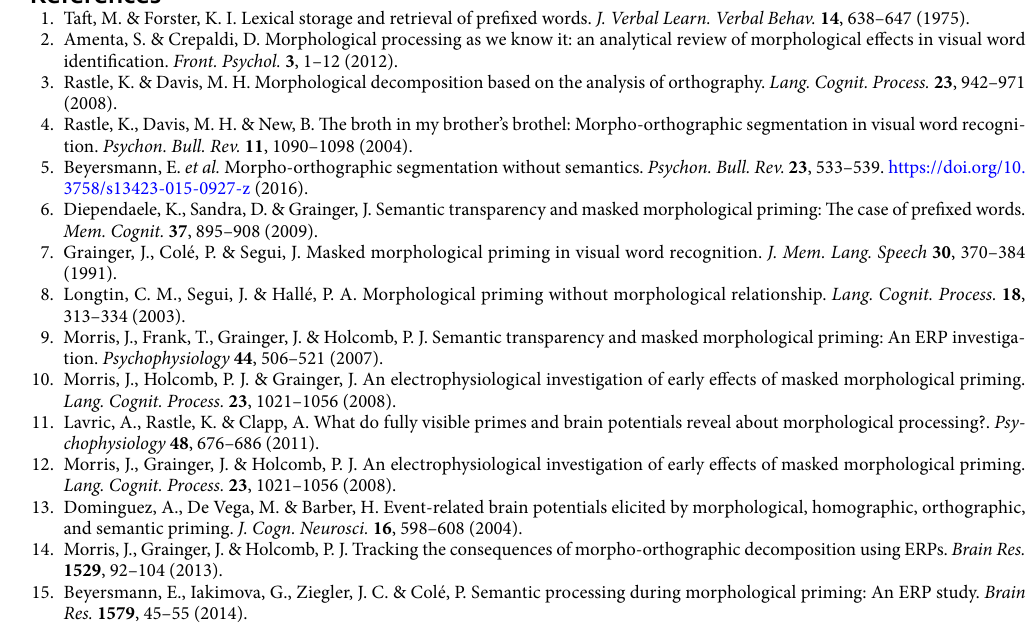
occurring at a pace that was different from the average (the higher the absolute value of the coefficient, the higher the pace). A negative quadratic coefficient was represented by a downward parabola, a trajectory that after rais- ing to the local maximum (i.e., positive peak) showed a decrement of magnitude. The cubic term reflected the presence of a point of inflexion (i.e., a change of concavity, from concave downward to concave upward or vice versa), with its coefficient representing the sharpness of the two peaks (local maximum and local minimum).